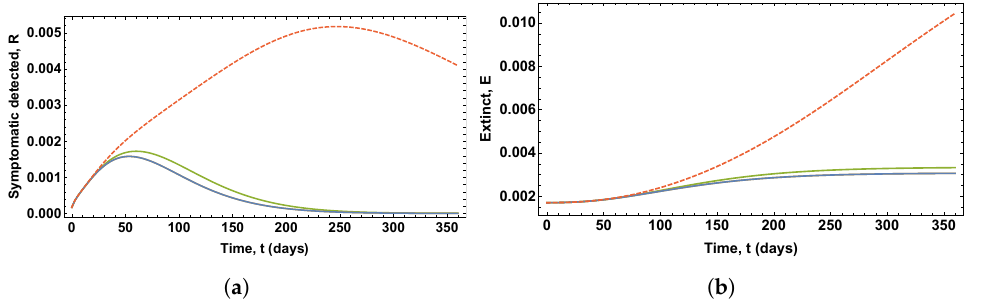
Figure 4. Proportions of people in each compartment for scenario 1 (blue), scenario 2 (orange), and scenario 3 (green). Proportions in dashed red lines were obtained while assuming that the vaccination term is omitted and considering the testing rate as a parameter: ( a ) Symptomatic detected people. ( b ) Extinct people.